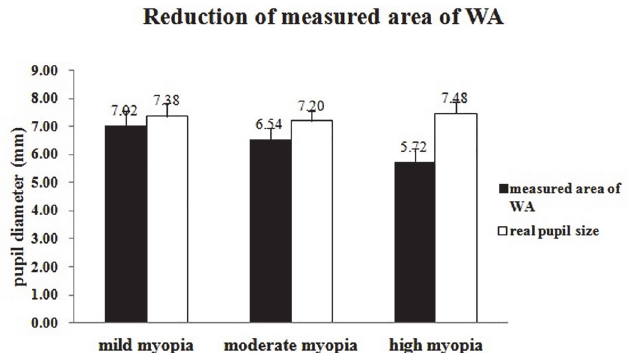
Fig 2. Reduction of measured area of wavefront aberration (WA) compared to real pupil size for different refractive groups. Error bars indicate one standard deviation from the mean. * indicates p < 0.05.